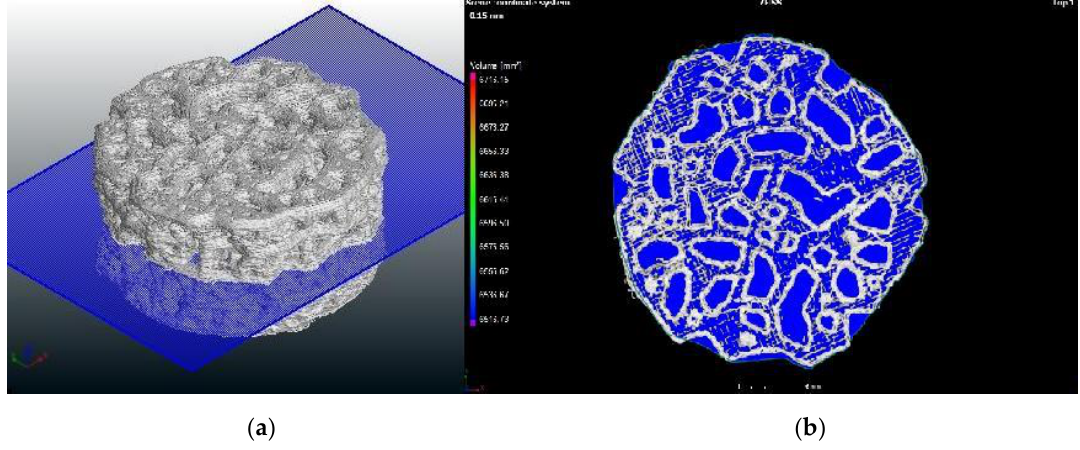
Figure 9. Cross-section of specimen 1: ( a ) 3D view, and ( b ) 2D view.